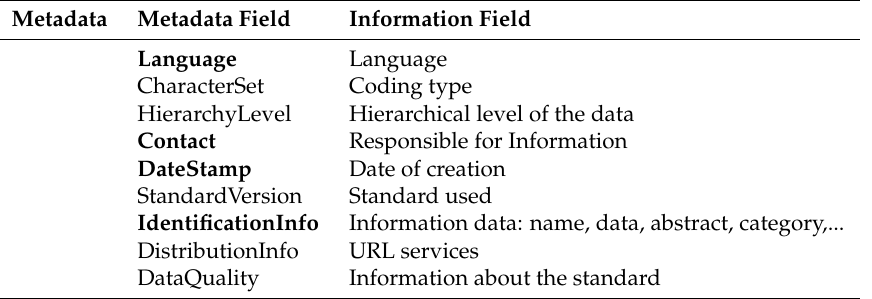
Table 1. Metadata fields (in bold indicates that the element is